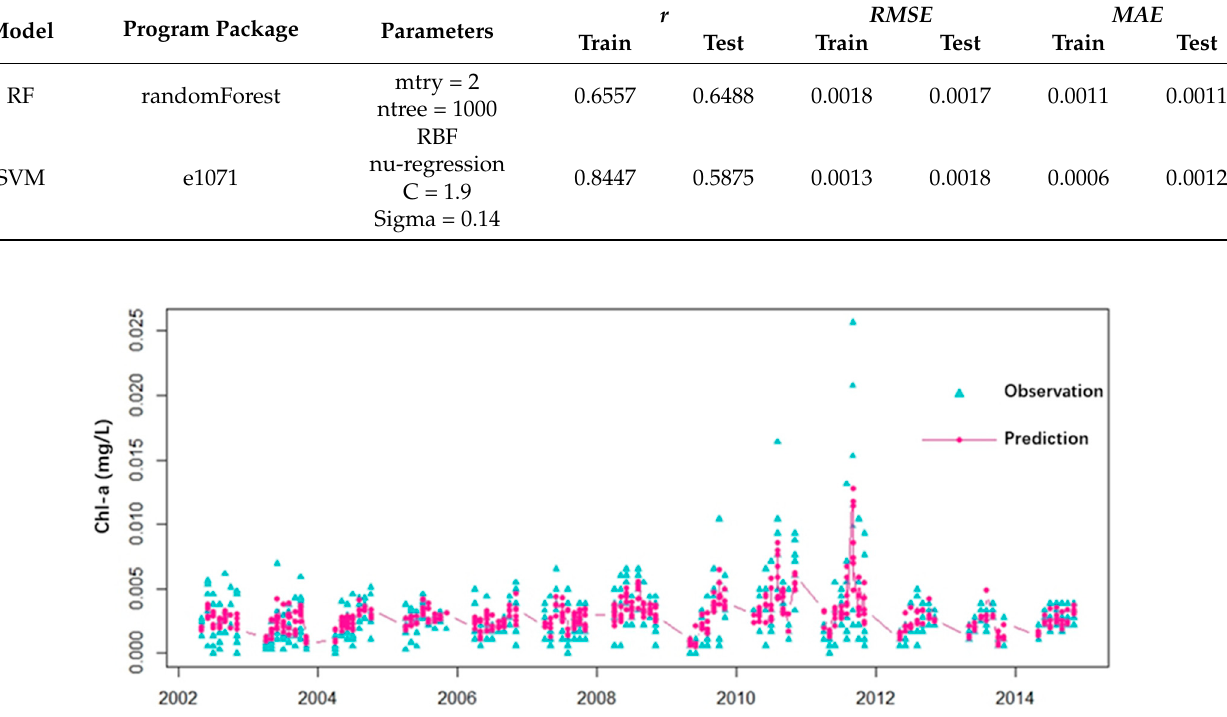
Table 3. Performances of two machine learning models on Chl-a concentration variations.